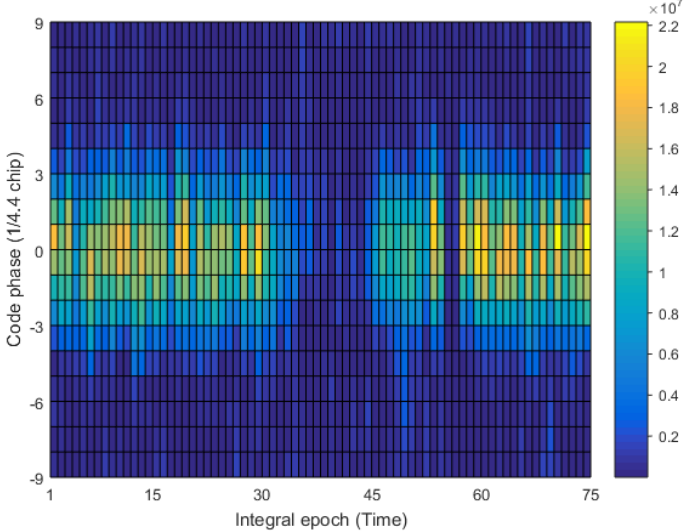
Figure 18. Fading channel distribution.